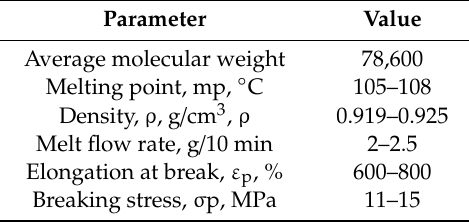
Table 1. The main characteristics of